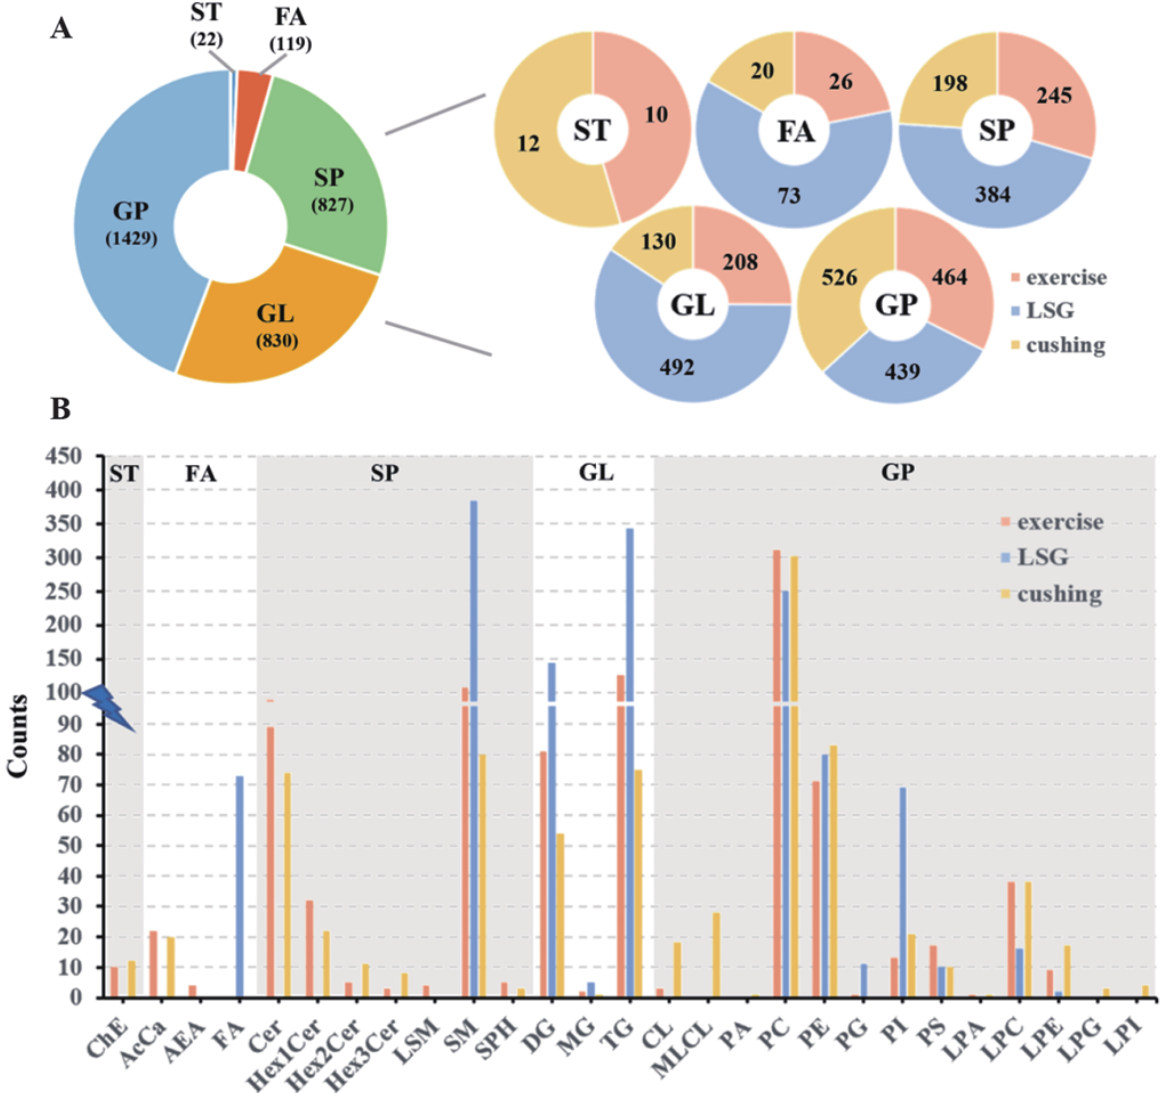
Figure 1. Non-targeted lipid classes. The exercise study was shown in orange, the LSG study was shown in blue, and the Cushing study was shown in yellow. ( A ) Pie charts depicting the counts of each lipid superclass. ( B ) Bar plot indicating the counts of each lipid subclass. ST: sterol